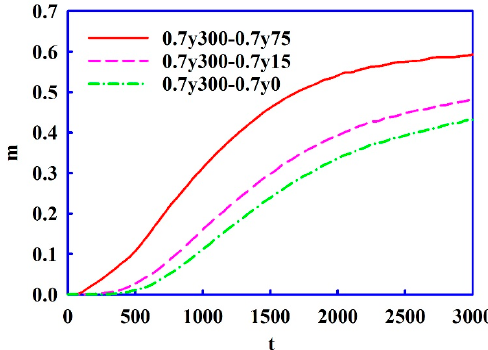
Figure 8. Normalized mixing efficiency m for mixing between a puff released at the channel center (puff A: Sc = 0.7, y o = 300) and puffs of the same Sc released at distances y o = 75, 15, and 0.